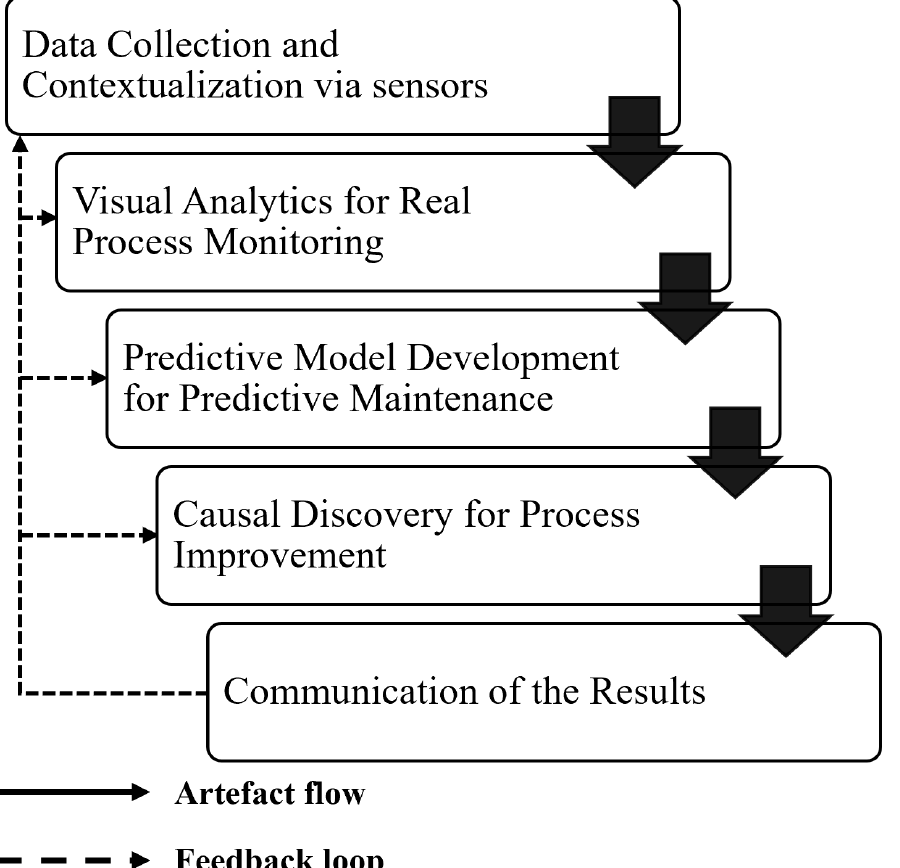
Figure 6. The model developed for cognitive data analysis. This model represents a sequence of study for a data-driven approach in the assembly